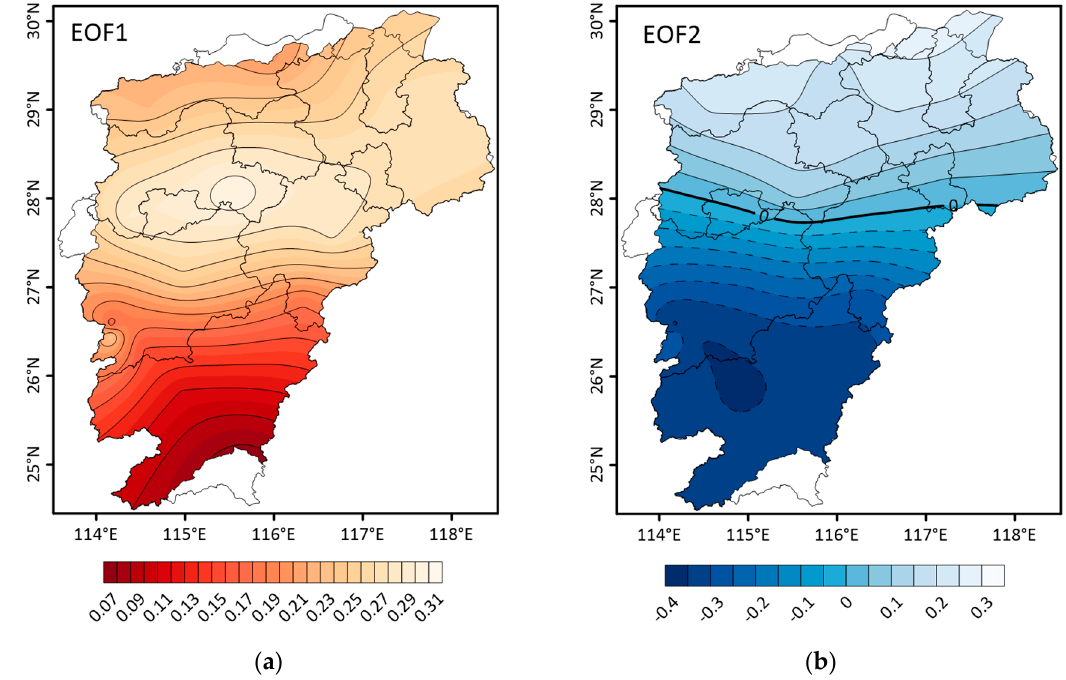
Figure 2. Spatial distribution of the first two leading Empirical Orthogonal Function (EOF) modes of summer precipitation in the Poyang Lake Basin (PYLB). ( a ) and ( b ) indicate the spatial distribution of EOF1 and EOF2 respectively.